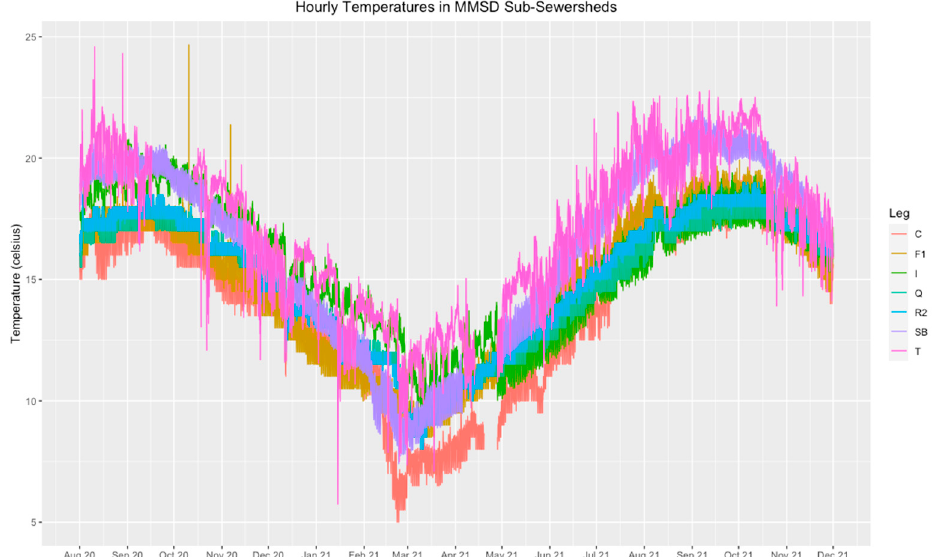
Figure 3. Hourly metered temperature readings from four representative subsewersheds in SS WWTP (within legs Q, R2, SB, T), and three representative subsewersheds in JI WWTP (within legs C, F1, I) over the course of this study.